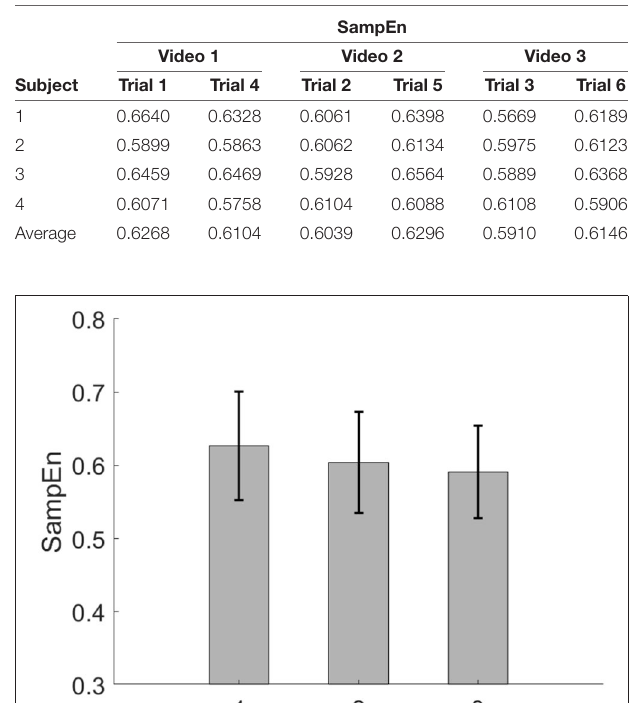
TABLE 1 | The values of SampEn for each subject.